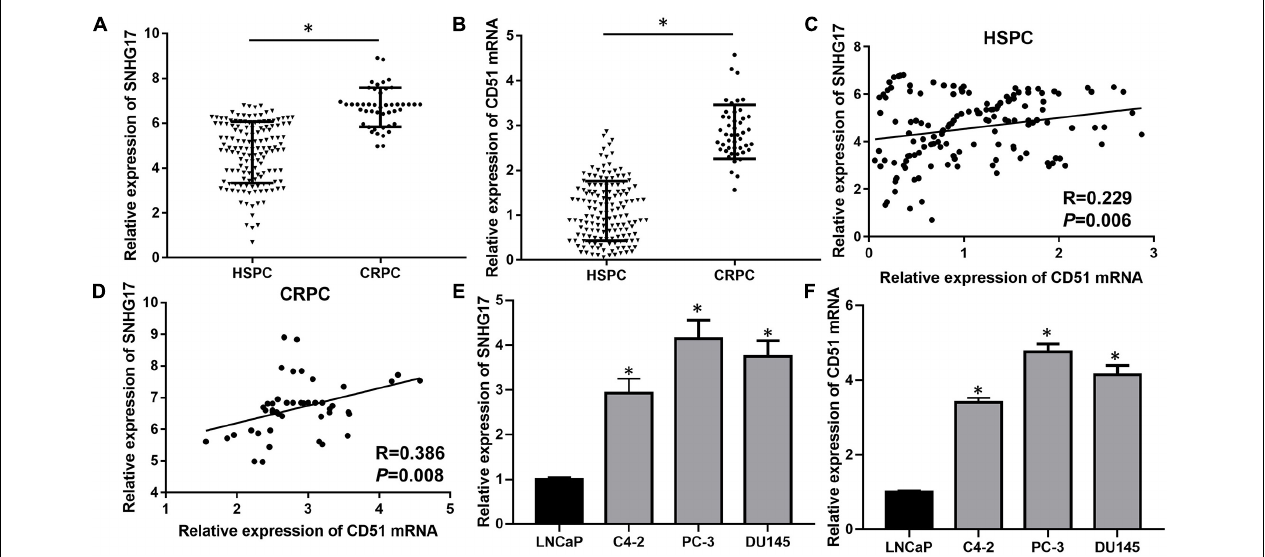
FIGURE 1 | SNHG17 expression was up-regulated and positively correlated with CD51 expression in CRPC tissues and cells. (A) The expression of SNHG17 in HSPC and CRPC tissues, as detected by RT-QPCR; (B) The mRNA expression of CD51 HSPC and CRPC tissues, as detected by RT-QPCR; (C) The association between CD51 and SNHG17 expression in HSPC tissues; (D) The association between CD51 and SNHG17 expression in CRPC tissues; (E) SNHG17 expression in HSPC cell line (LNCaP) and CRPC cell lines (PC-3 and C4-2), as detected by RT-QPCR; (F) The expression of CD51 in HSPC cell line (LNCaP) and CRPC cell lines (PC-3 and C4-2), as detected by RT-QPCR; Data expressed as the mean ± SE . * P < 0.05, ns, not significant. The representative results of 3 independent experiments are